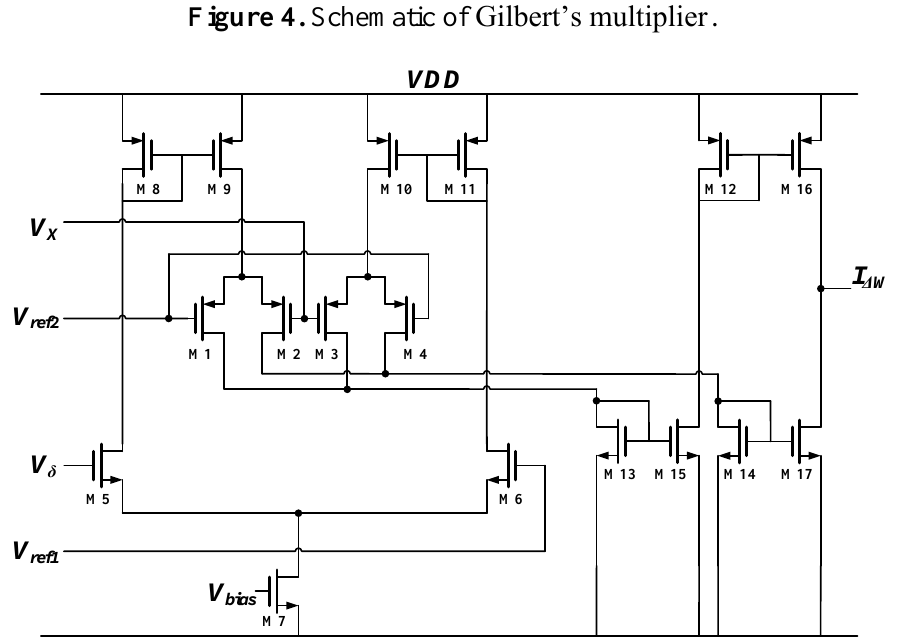
Figure 4. Schematic of Gilbert’s